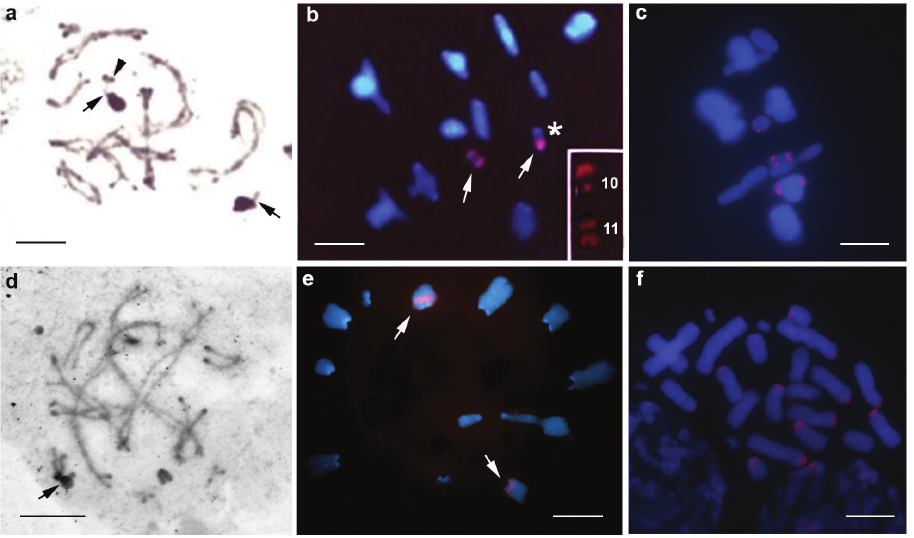
Figure 5. Mitotic and meiotic cells of T. collaris ( a, b, c ) and T. cristata grandis ( d, e, f ). a, d silver nitrate impregnation b, e FISH with 18S rDNA probe c, f FISH with histone H3 gene probe. Black and white arrows, arrowheads and asterisk indicate Ag-NOR bands, rDNA sites, pericentromeric regions and chromosome pair no. 10 respectively (heterozygous condition shown in the box). Bar = 10